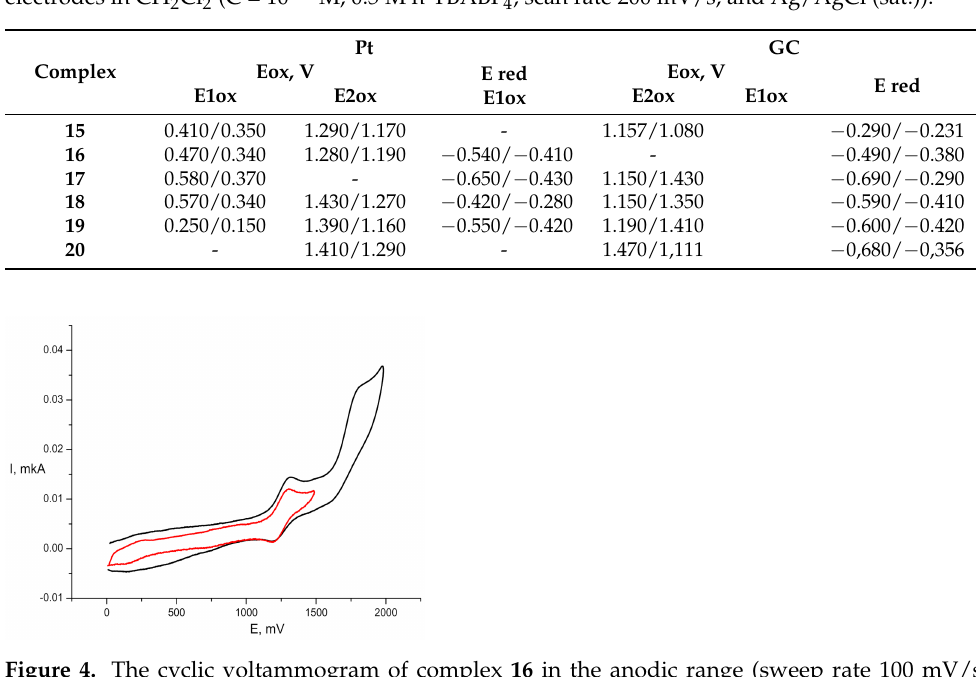
Table 3. Redox potentials of complexes determined with a Pt and the glassy carbon (GC) working